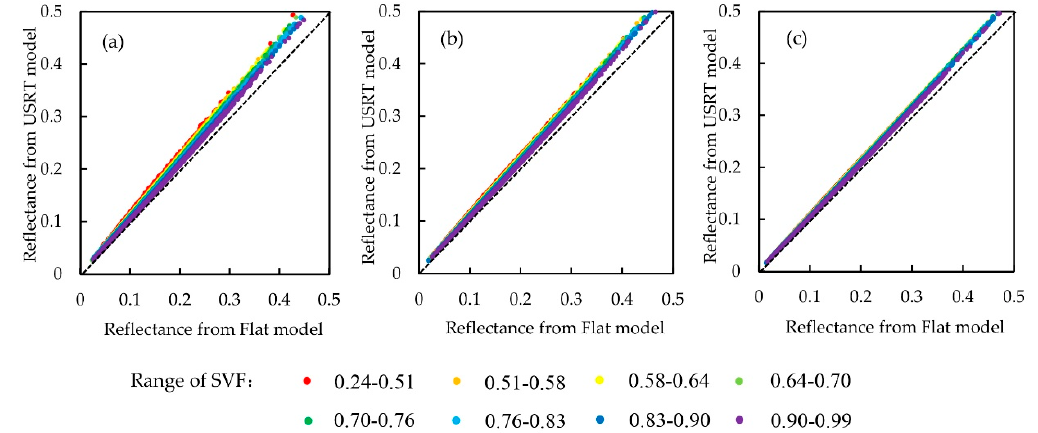
Figure 8. Reflectance comparison of the two models with different SVFs. Note: ( a ) comparison of blue band reflectance from the two models; ( b ) comparison of green band reflectance from the two models; ( c ) comparison of red band reflectance from the two models.